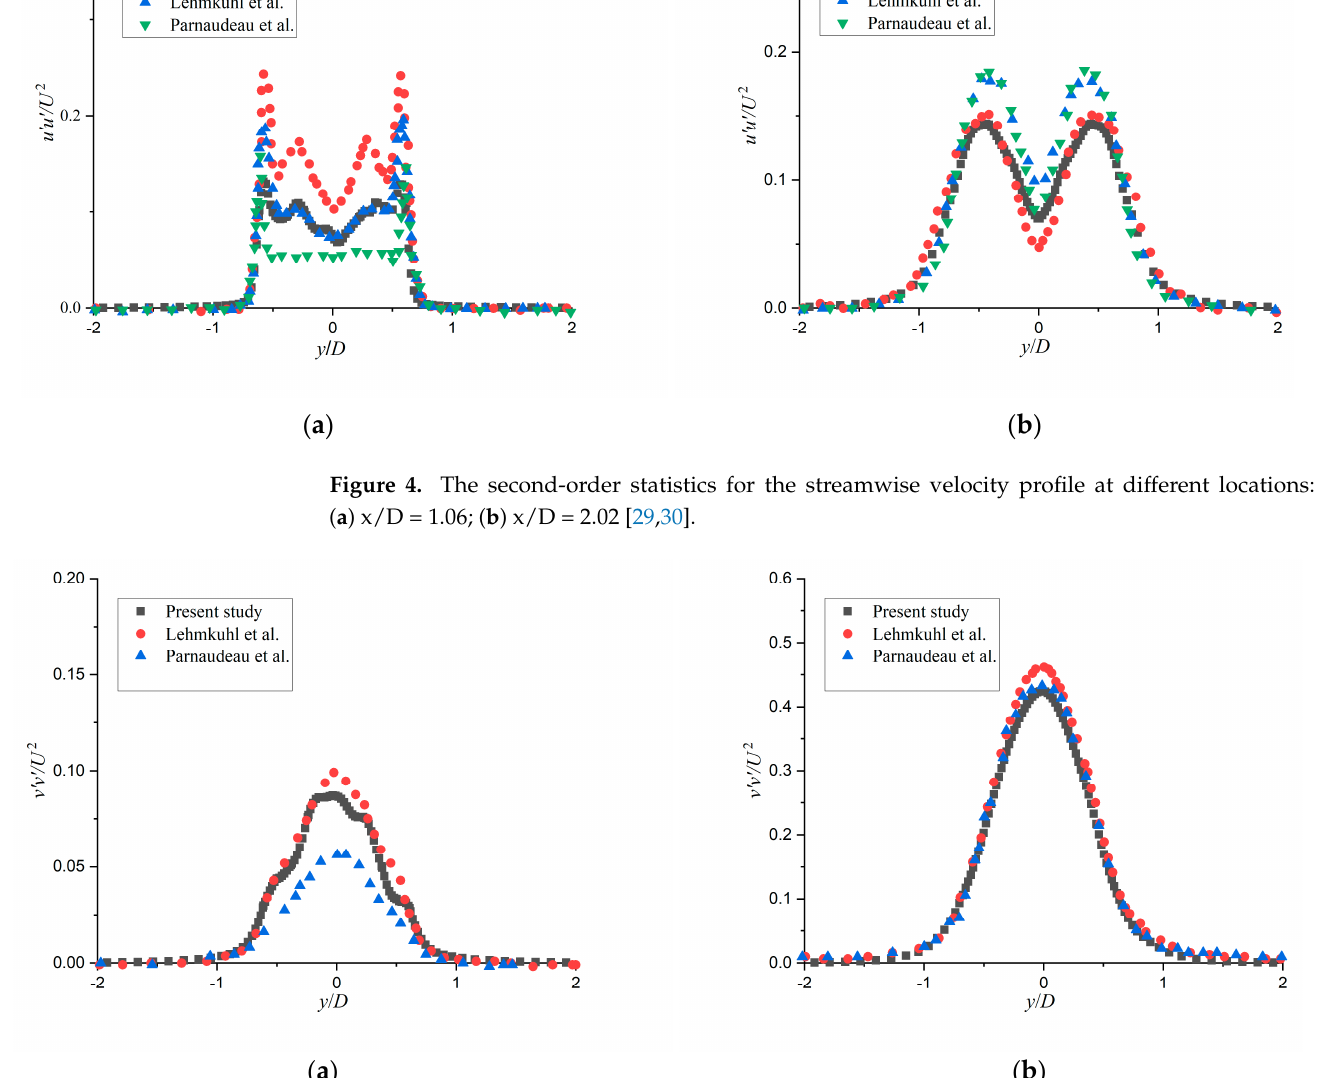
Figure 5. The second-order statistics for the cross-flow velocity profile at different locations: ( a ) x/D = 1.06; ( b ) x/D = 2.02.